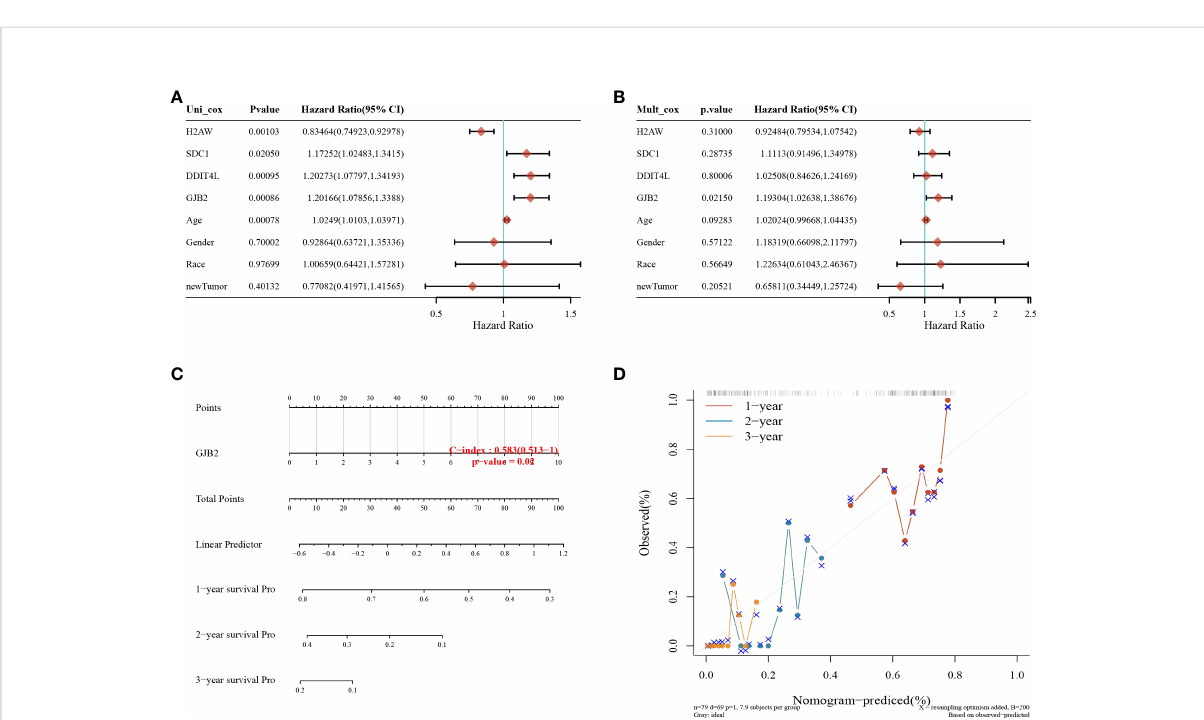
FIGURE 6 Nomogram analysis. (A) Univariate and (B) multifactorial Cox analyses showing that the GJB2 gene is an independent prognostic factor for GBM; (C) columnar plots predicting 1, 2, and 3-year overall survival in GBM patients; (D) calibration curves for the overall survival columnar plot model.